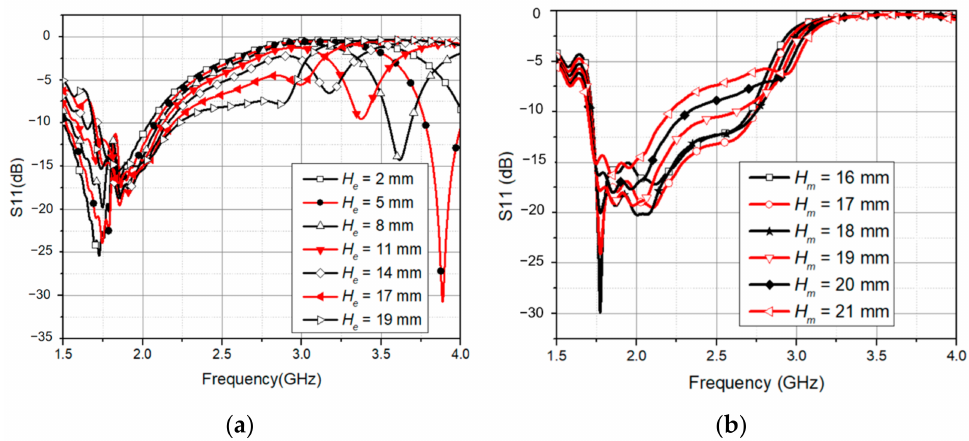
Figure 2. ( a ) Effect of H e on the reflection coefficient; ( b ) effects of H m on the reflection coefficient. Table 1. The dual-dipole antenna dimensions. Para. Val. (mm) Para. Val. (mm)